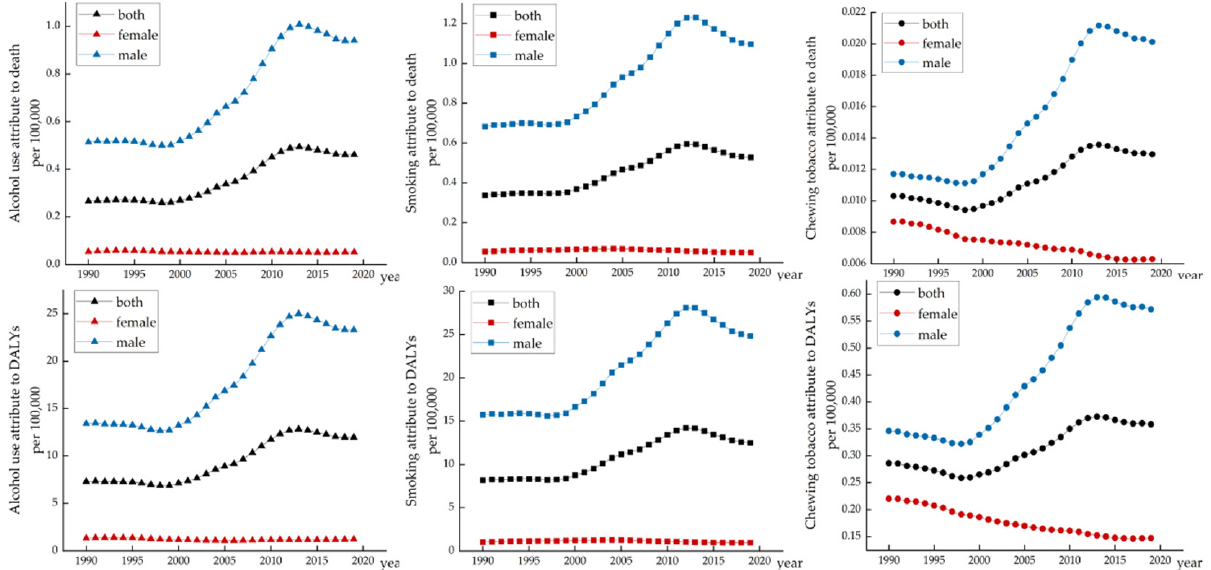
Figure 3. The variation trends of ASDR and age-standardized DALY rate of three risk factors in different genders over 30 years.